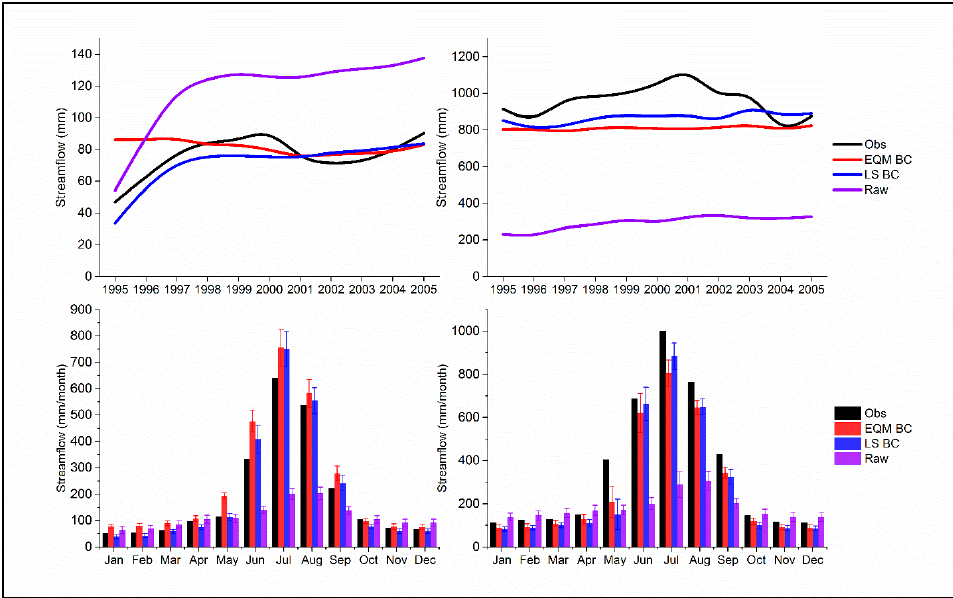
Figure 4. Top left: inter-annual time-series of 7-day minimum streamflow, as provided by observed station data (Obs) and the ensemble mean of the 21 NEXGDDP models when they were LS-corrected (LS BC), EQM-corrected (EQM BC), and their raw outputs (Raw) were considered for the reference period (1995–2005). Top right: as top left, but for 7-day maximum streamflow. Bottom panels: as Figure 3, but for 10th percentile (left) and 90th percentile (right) streamflow throughout 1995–2005.